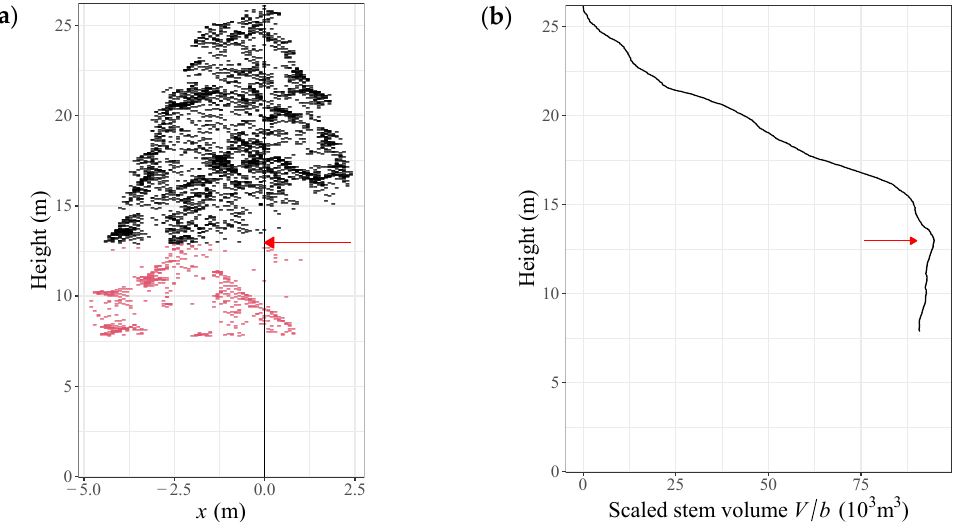
Figure 6. ( a ) Example of a tree shape segmented from a canopy height model by the watershed method. ( b ) Scaled stem volume V / b change by height of the individual in ( a ) calculated by Equation (9). The red arrows represent the height at which V / b reaches its maximum, and red leaves on ( a ) are the leaves below the height of the arrows.